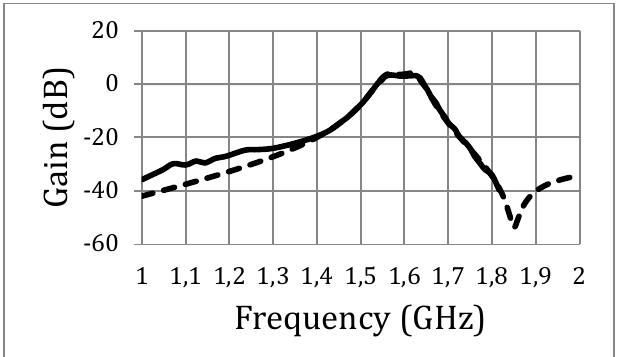
Fig. 11. Gain vs. frequency in the extended frequency band: solid – measured, dashed – simulated.